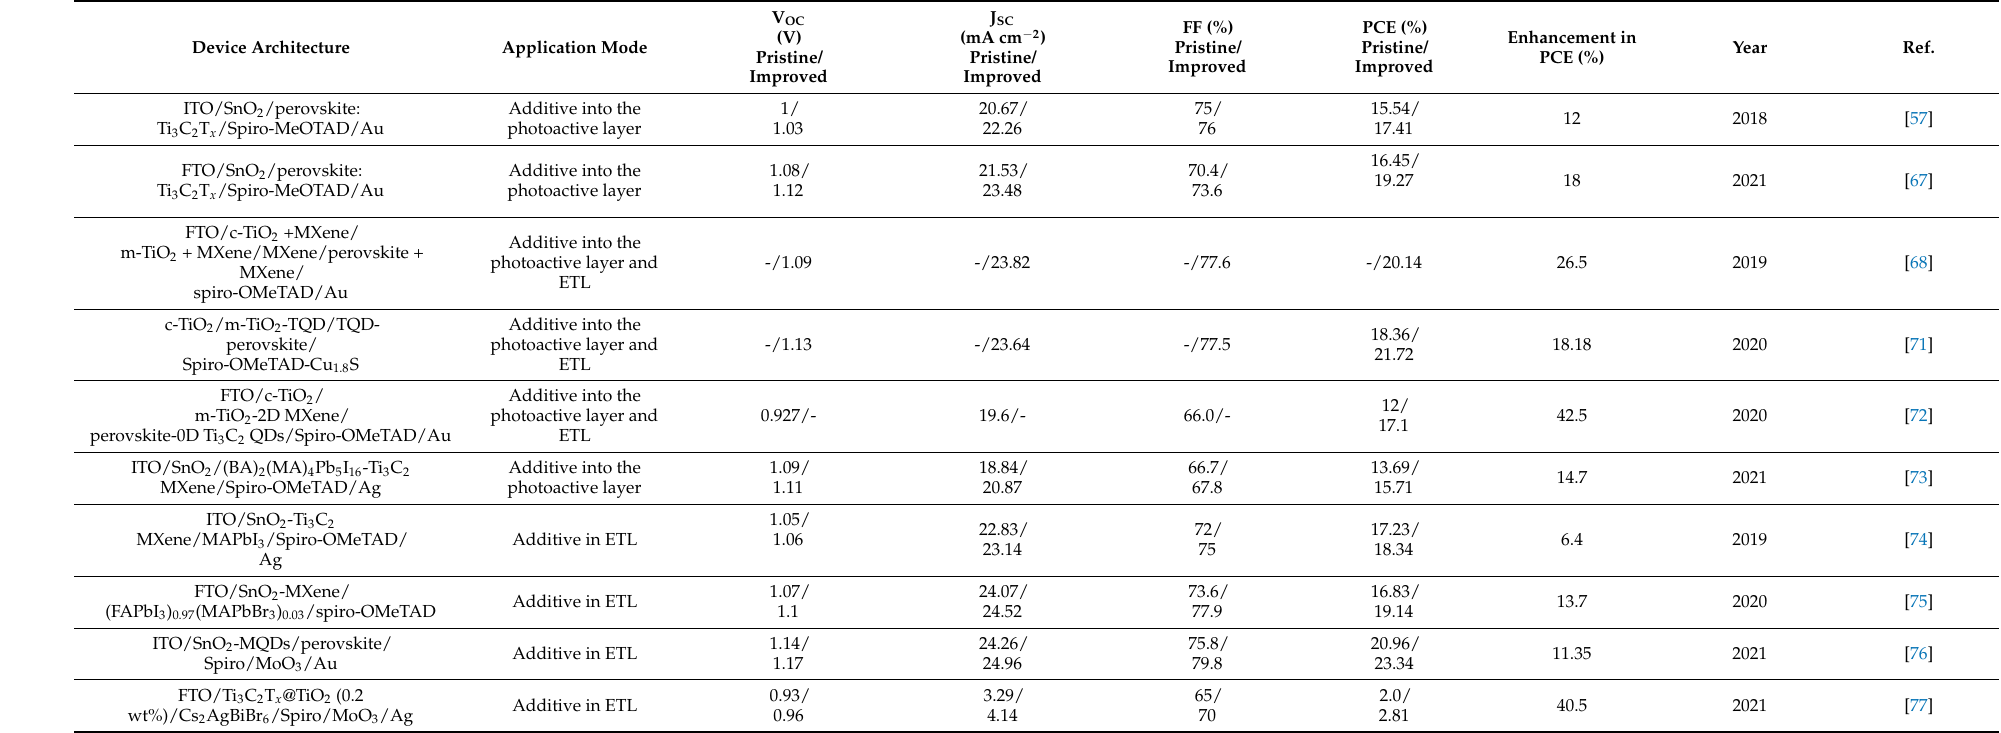
Table 1. Summary of the works reporting the incorporation of MXene (Ti 3 C 2 T x ) in